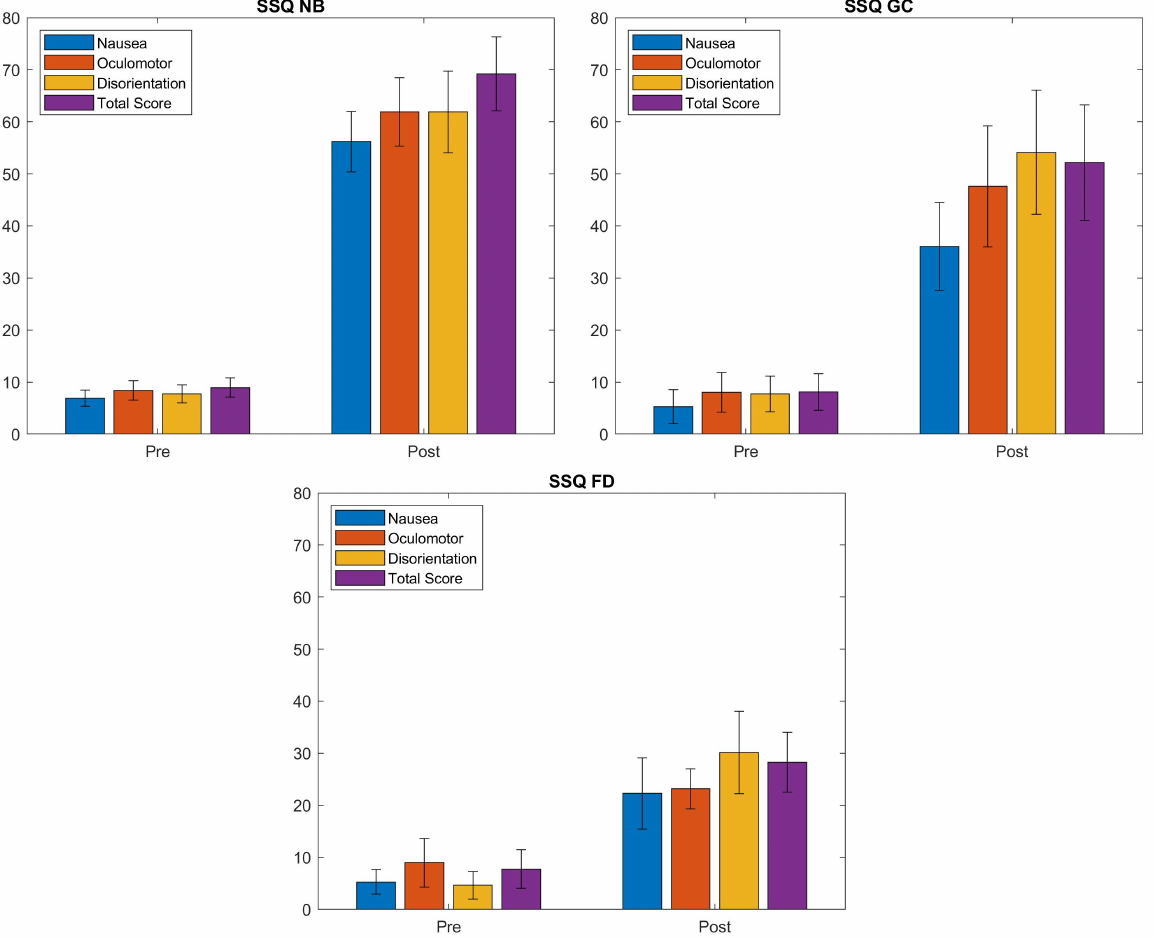
Figure 11. SSQ scores for the cybersickness experiment (conditions: NB—No Blur; GC—Unity Blur; FD—Ours). The ques- tionnaire was filled before (Pre) and after (Post) each session. Each plot shows the mean values, averaged over all the participants, and the standard deviations for the three sub-scales and the overall score.